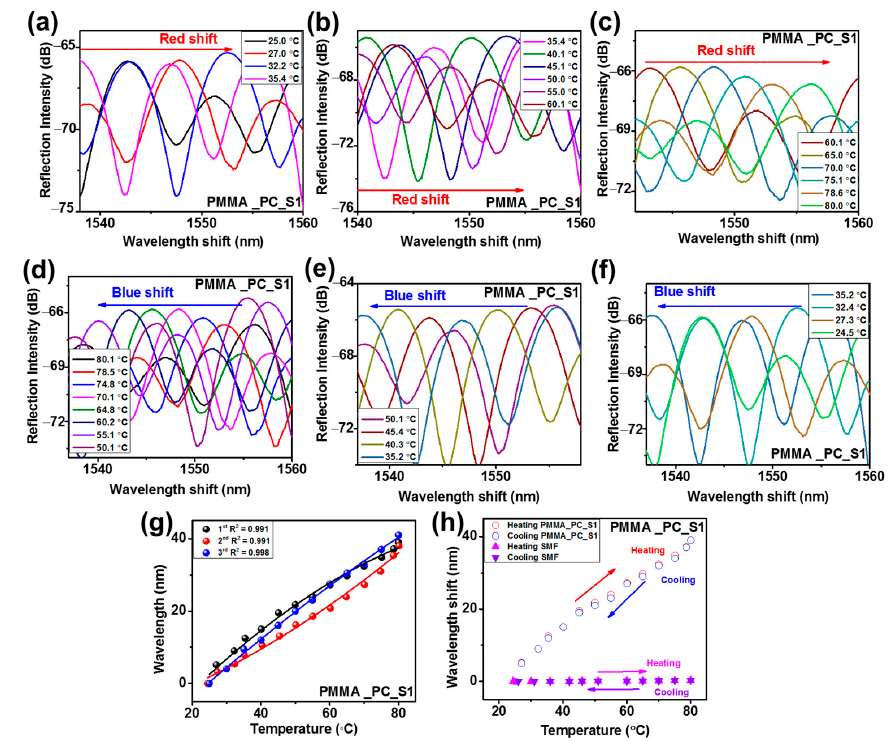
Figure 7. Reflected spectra with increase in temperature ( a – c ), with decrease in temperature ( d – f ), wavelength shift for three measurements ( g ), and ( h ) average wavelength shift associated with SMF for PMMA_PC_S1 DPFPI.